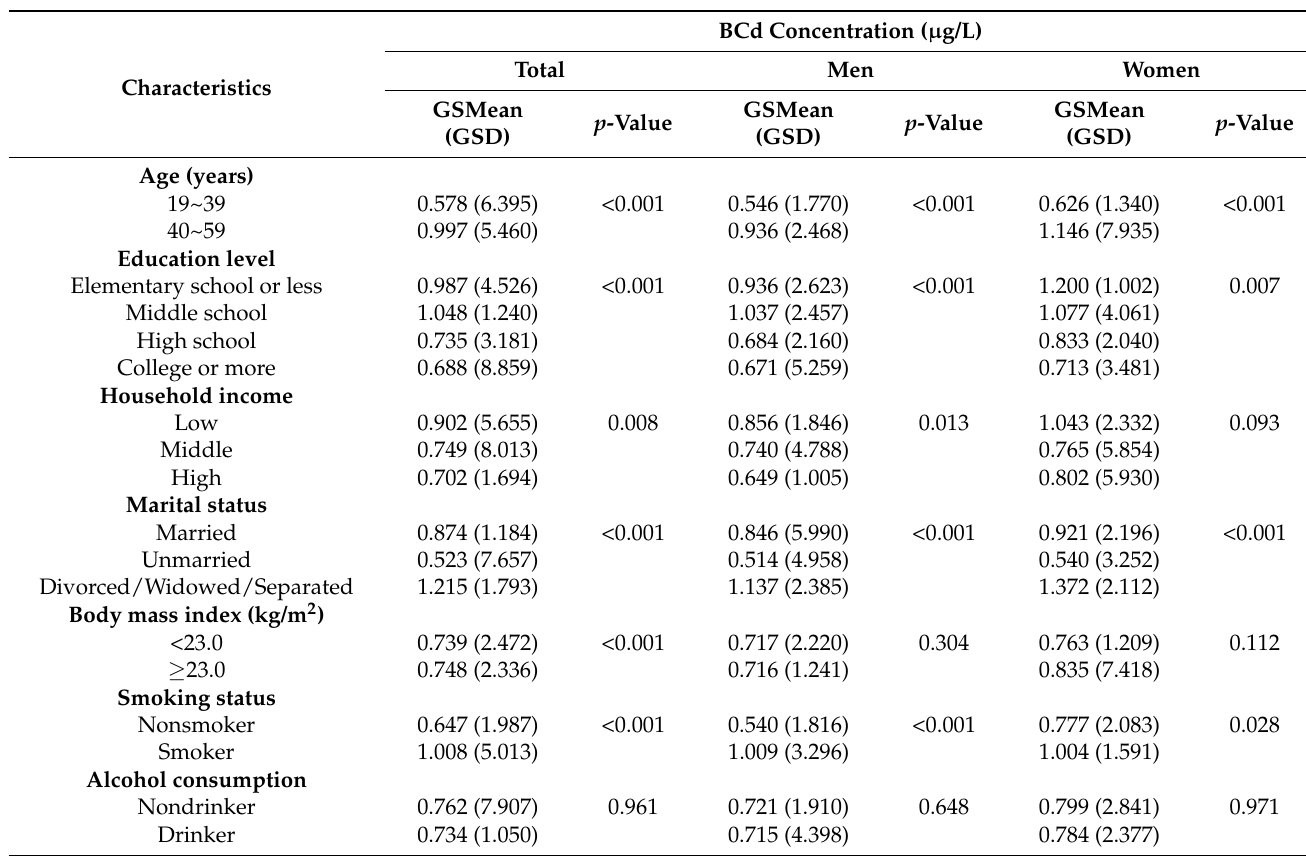
Table 3. BCd Concentrations( µ g/L) according to characteristics of study population.